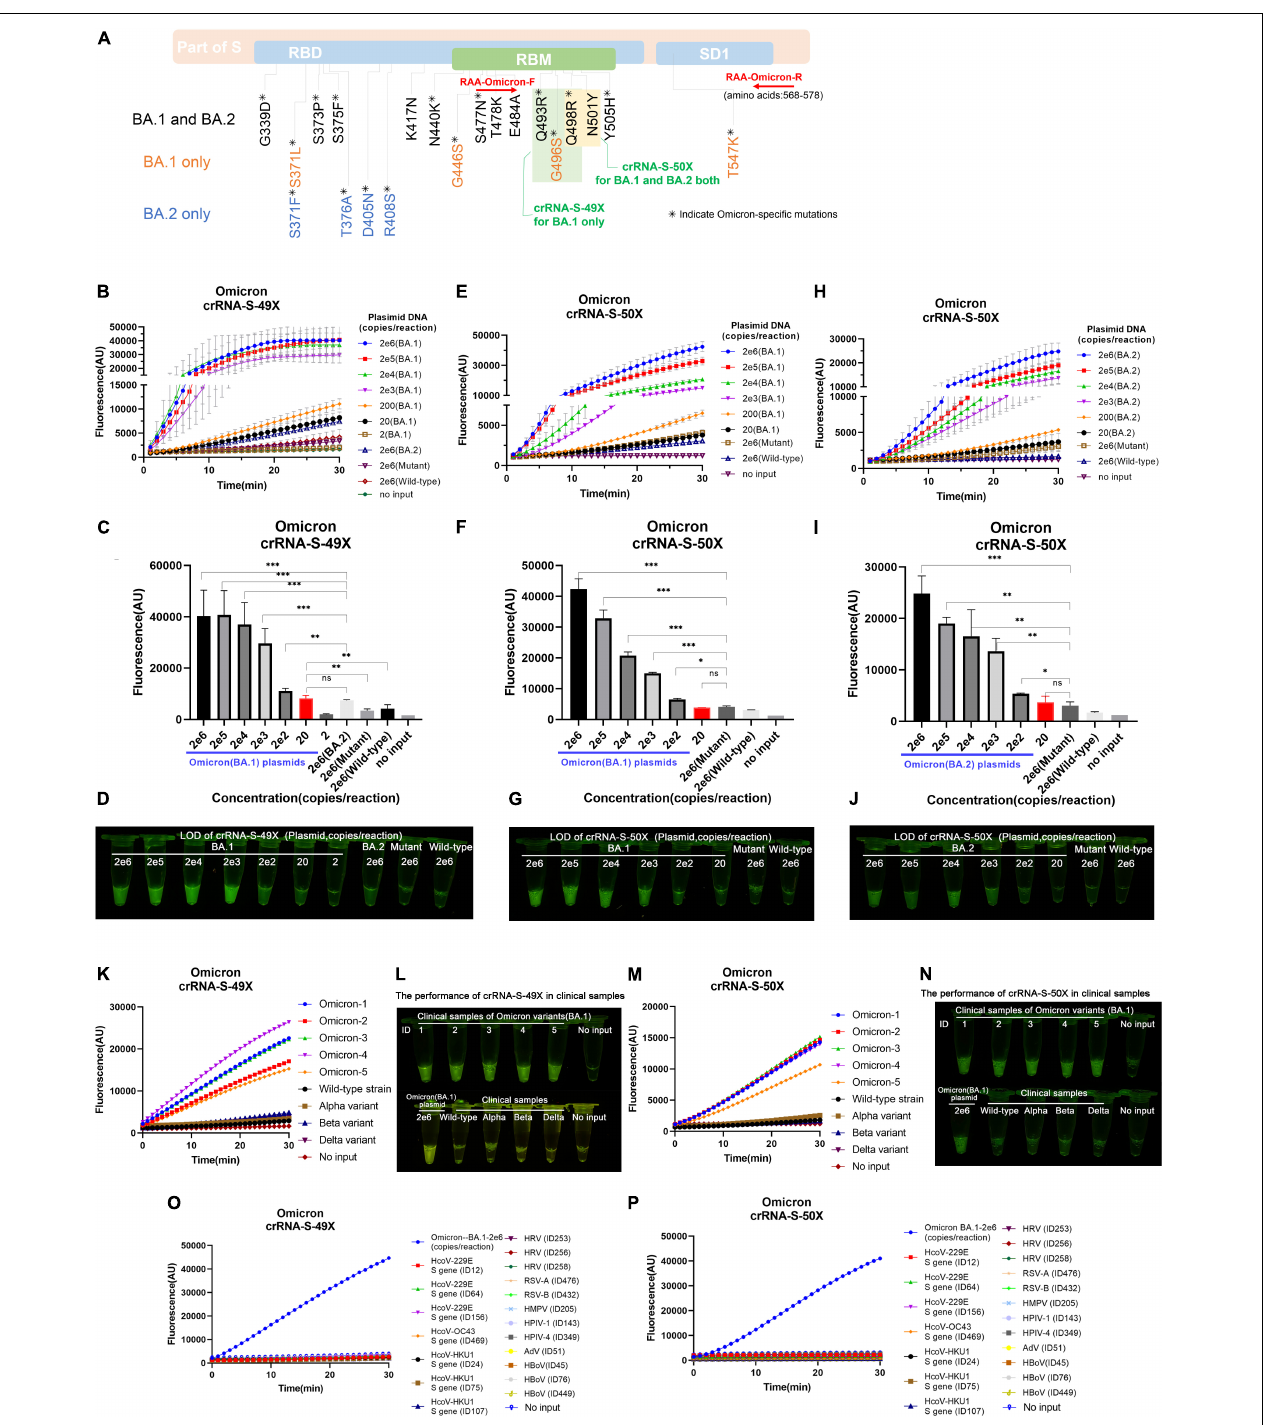
FIGURE 5 | Detection of Omicron BA.1 and BA.2 sublineages via optimized RAA/CRISPR-Cas12a-mediated assay by using crRNA-S-49X and crRNA-S-50X. (A) The schematic of the specific mutations and the RAA primers. The shared mutations of BA.1 and BA.2 (black) and the mutations specific for BA.1 (yellow) or BA.2 (blue) were presented, while the RAA primers were labeled in red. A series of 10-fold diluted synthetic SARS-CoV-2 plasmid DNAs of wild-type, SARS-CoV-2 mutant, and Omicron BA.1 and BA.2 sublineages were used as the templates for RAA/CRISPR-Cas12a-mediated assay. The low limit of detection was determined and quantitatively analyzed for BA.1 template by using crRNA-S-49X (B,C) and crRNA-S-50X (E,F) , whereas the LOD of crRNA-S-50X was analyzed using BA.2 template (H,I) . Testing results were visualized by the naked eyes under blue light at 30 min post-reaction (D,G,J) . Five clinical samples infected with BA.1 sublineage could be specifically distinguish from other SARS-CoV-2 VOCs-infected samples by using crRNA-S-49X (K,L) and crRNA-S-50X (M,N) . Both crRNA-S-49X (K) and